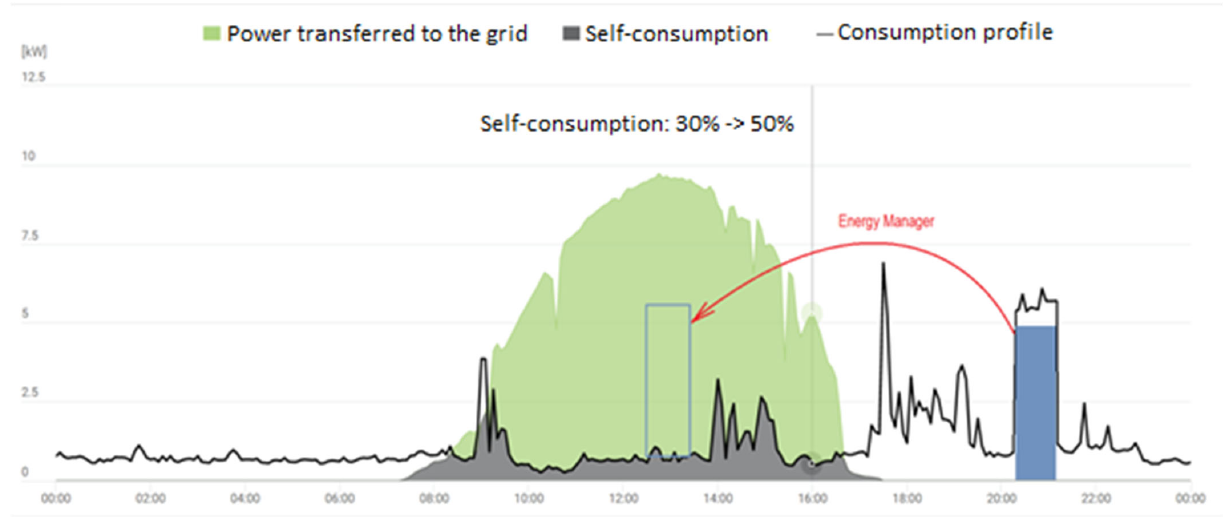
Figure 8. Load and electricity production profile for a single-family house [55].